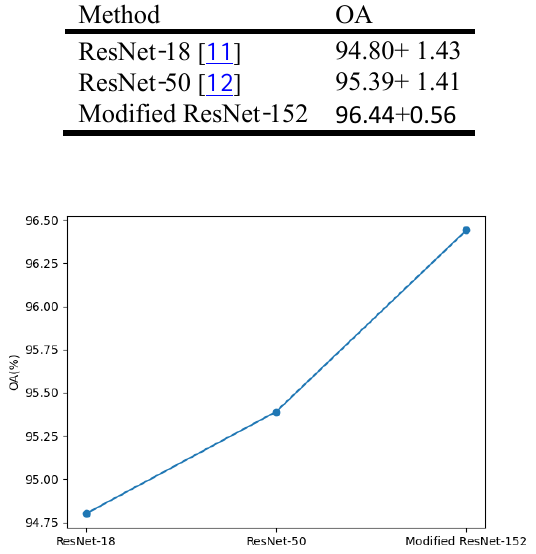
Figure 11. The trend of OA of ResNet variants Swarm intelligence is a potential way to